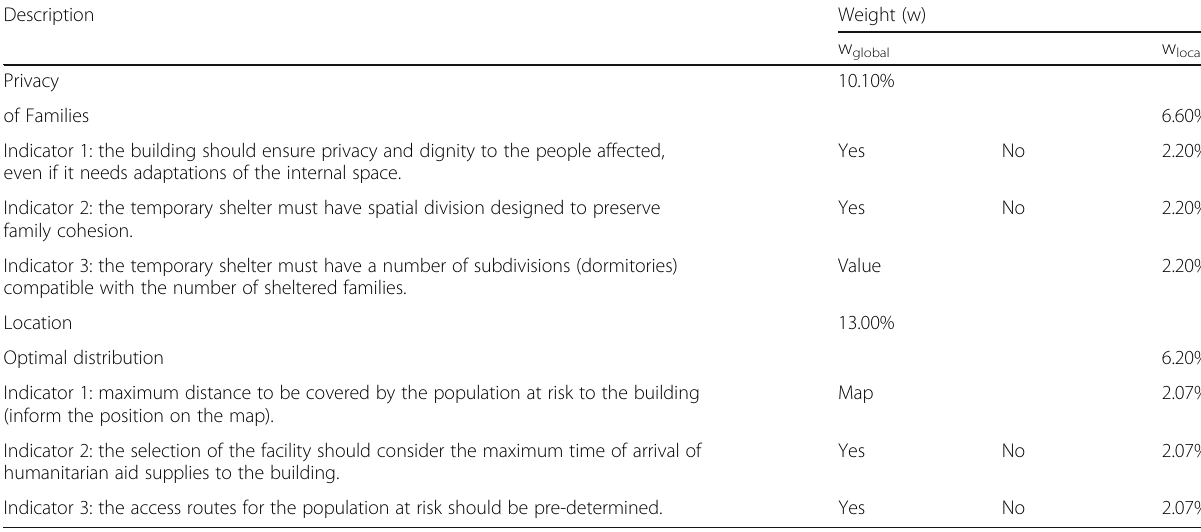
Table 1 Examples of the “ Privacy ” and “ Location ” global criteria with weights (w global : global weight, w local : local